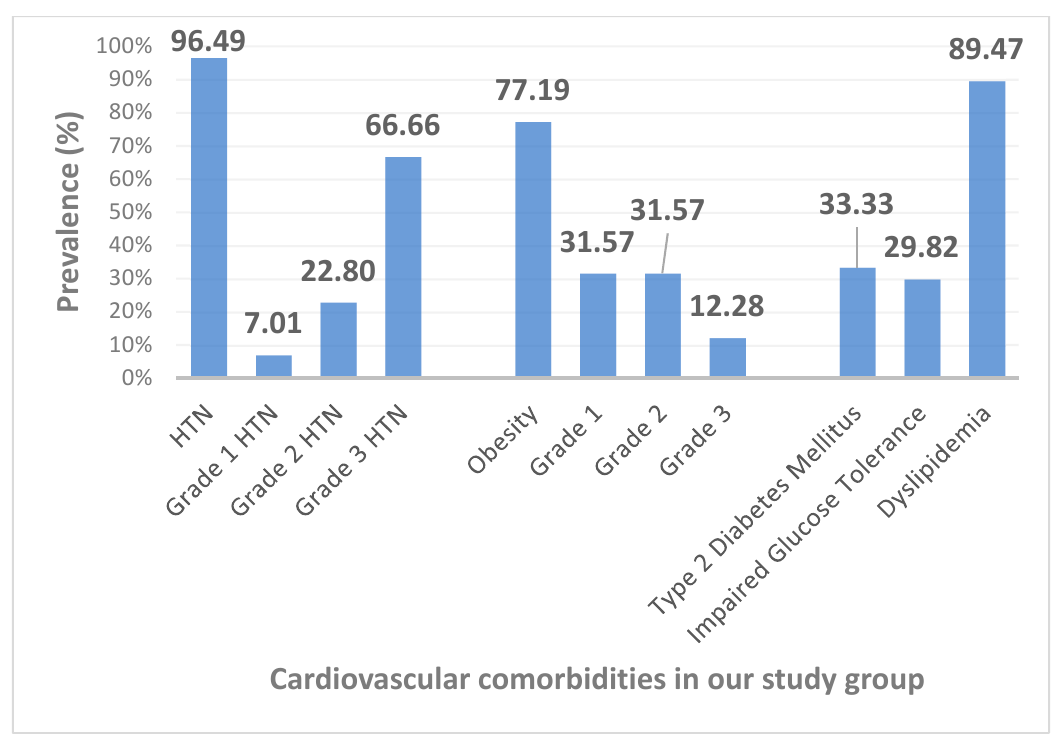
Figure 1. Prevalence of cardiometabolic comorbidities in patients with moderate-severe OSA. OSA—obstructive sleep apnea; HTN—hypertension. Table 2. Baseline echocardiographic parameters in our study